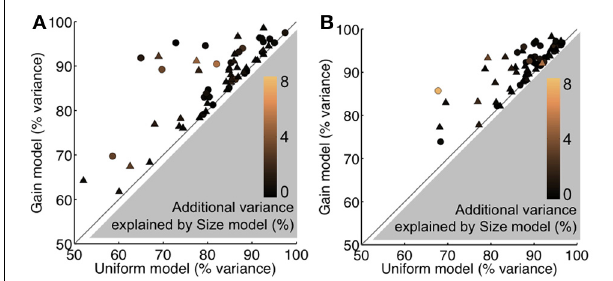
FIGURE 7 | Constrained model comparisons. (A) Variance explained per unit during the Control condition, plotted for the gain model vs. uniform model. Color scale indicates additional variance explained by the size model relative to gain model. Gray region cannot be occupied because the gain model has one additional parameter than the uniform model. Similarly, the color scale is non-negative because the size model has one additional parameter than the gain model. (B) Same format as (A) for the Feedback inactivation condition. The gain model considerably improves the goodness-of-fit, while only slight improvements are observed with the size model. For all panels, triangles and circles indicate single- and multi-units,